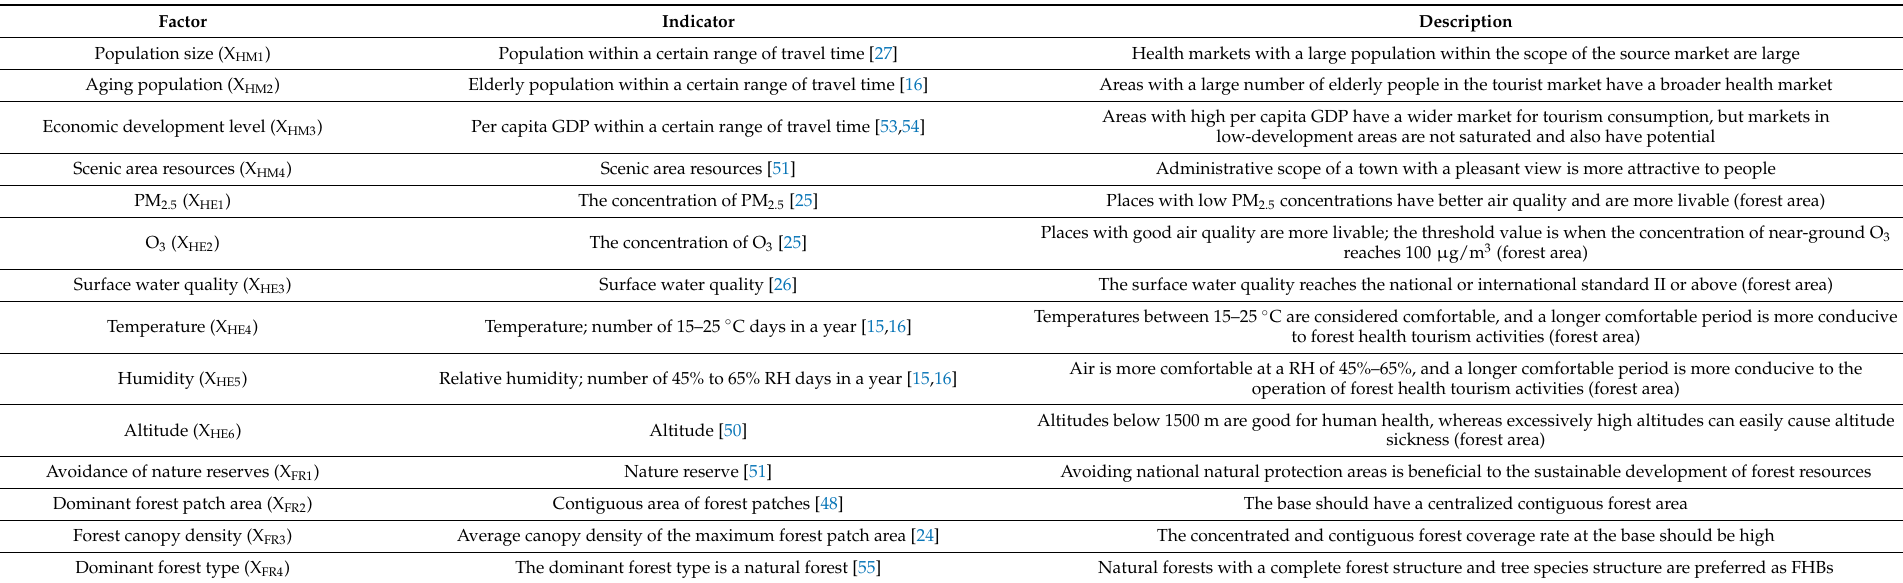
Table 2. The descriptions of the evaluation criteria for the sustainable site selection and construction of